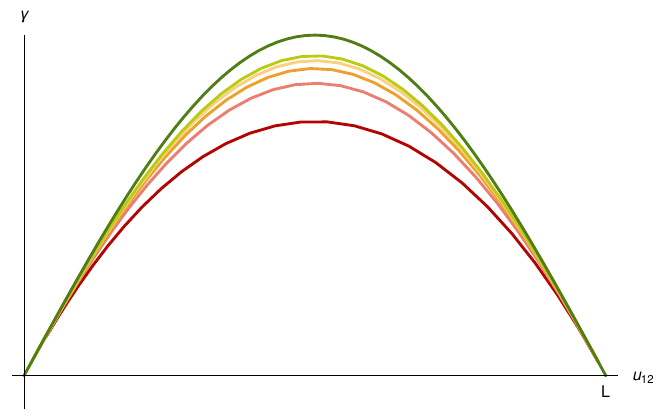
Figure 11 . (cid:13) ( u 12 ) for various masses, the curves becoming greener as mass decreases. The dark green line is the conformal result (cid:13) = L=(cid:25) (cid:1) sin ( (cid:25)u 12 =L ).